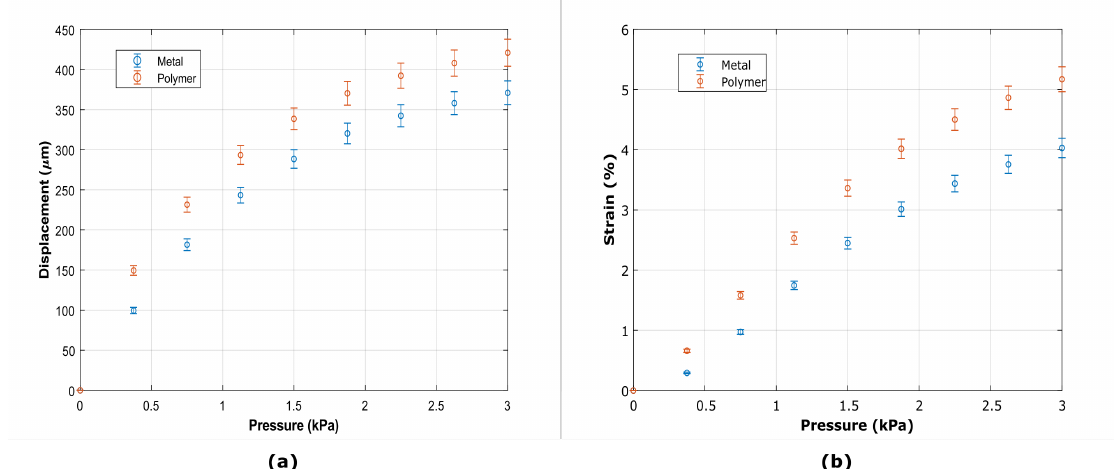
Figure 9. ( a ) Displacement in the center of the membranes with metal and polymeric strain gauges measured optically for different pressures set through the pumping system (1–3 kPa). ( b ) Estimation of the radial strain of the membranes with strain gauges based on the displacement measurements. Error bar: